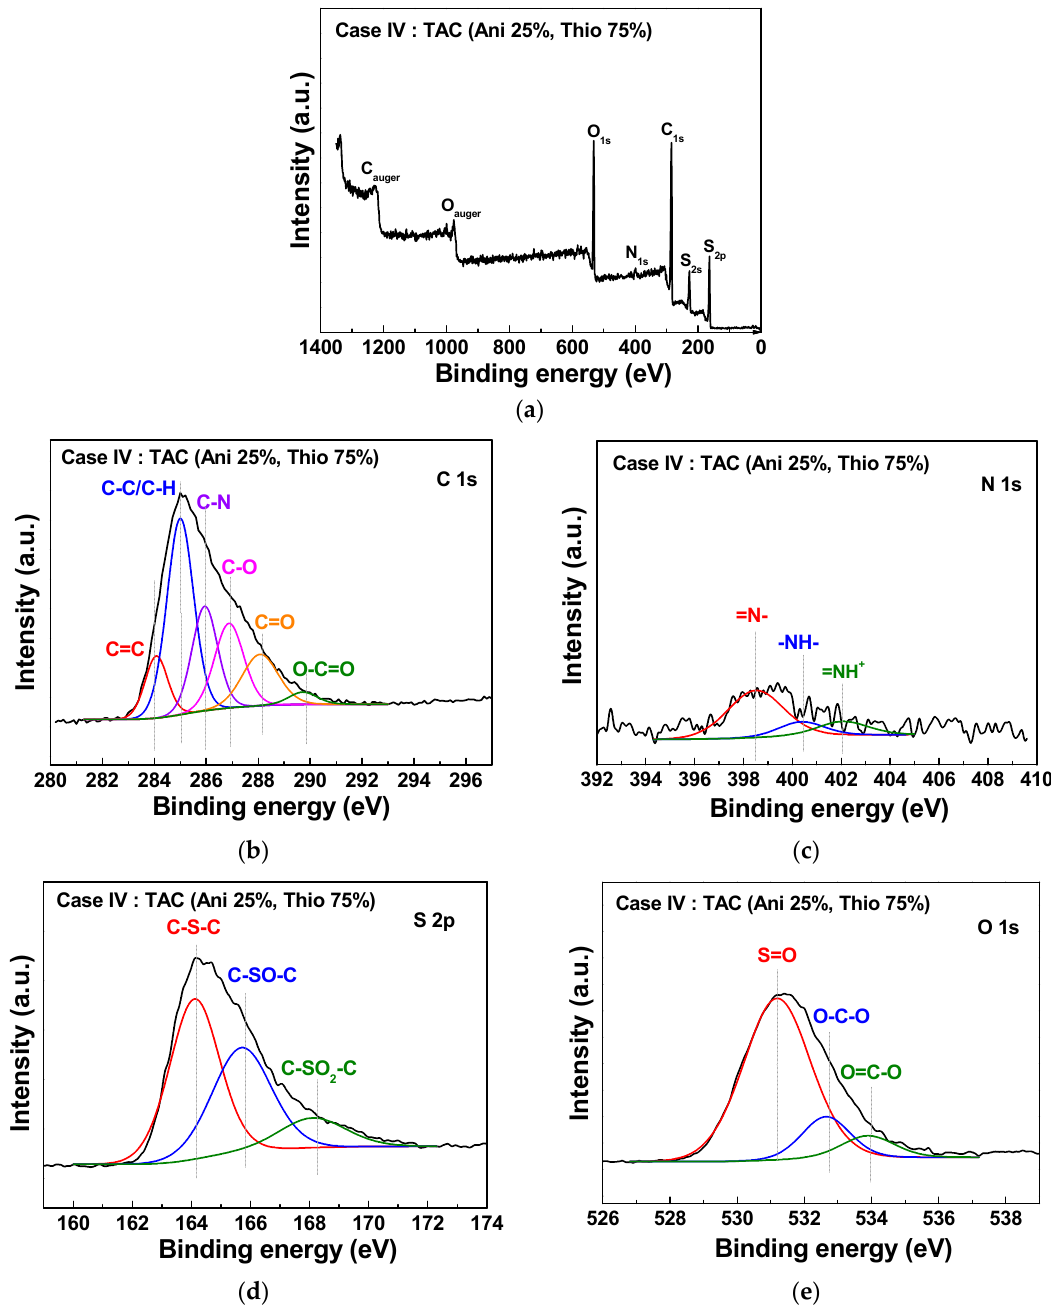
Figure 7. XPS survey spectra ( a ) and detailed high-resolutions with deconvolutions ( b – e ) of TAC films deposited on glass substrates by APPJs polymerization at blending condition of case II (aniline 75% and thiophene 25%).